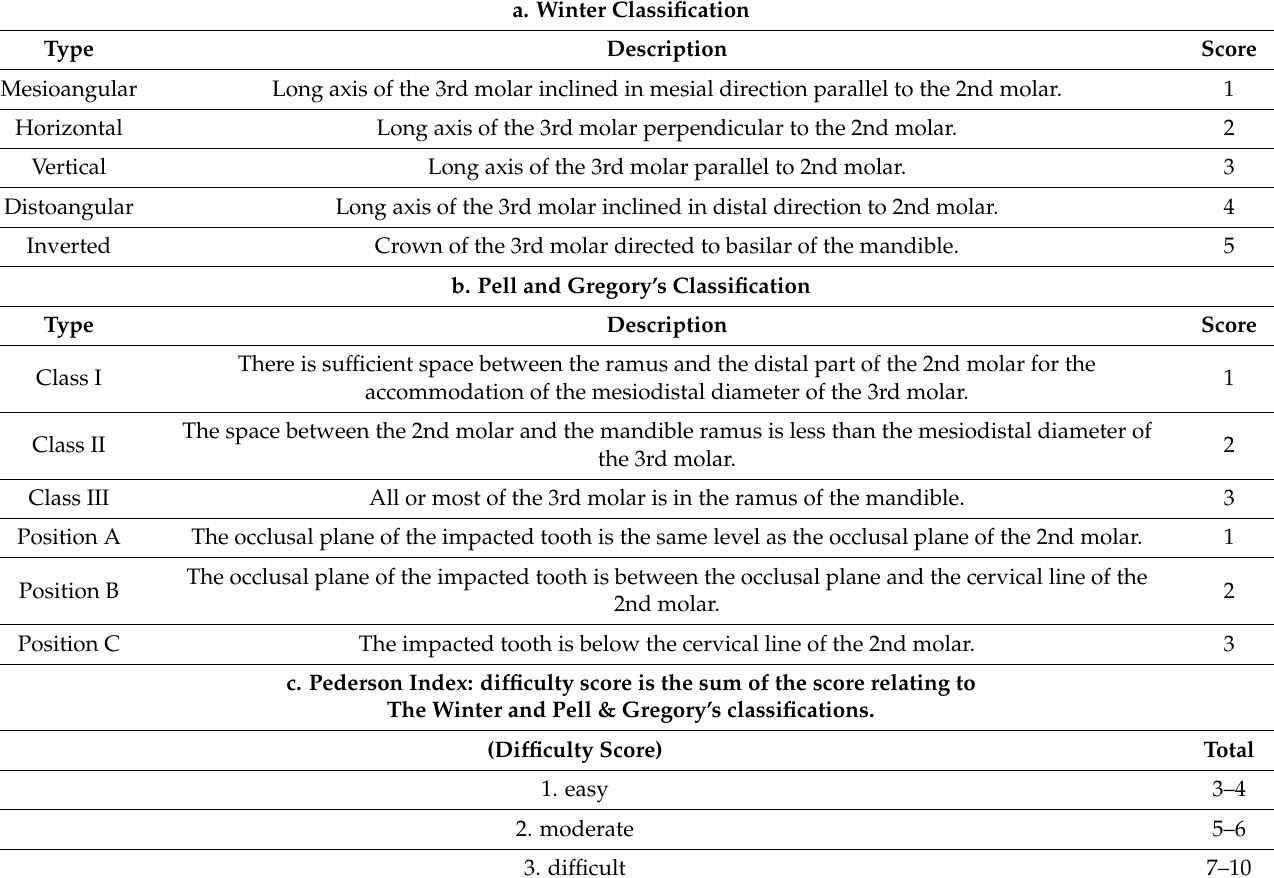
Table 2. a. Winter classification, b. Pell and Gregory’s classification, and c. Pederson index: difficulty score is the sum of the score relating to Winter’s and Pell and Gregory’s